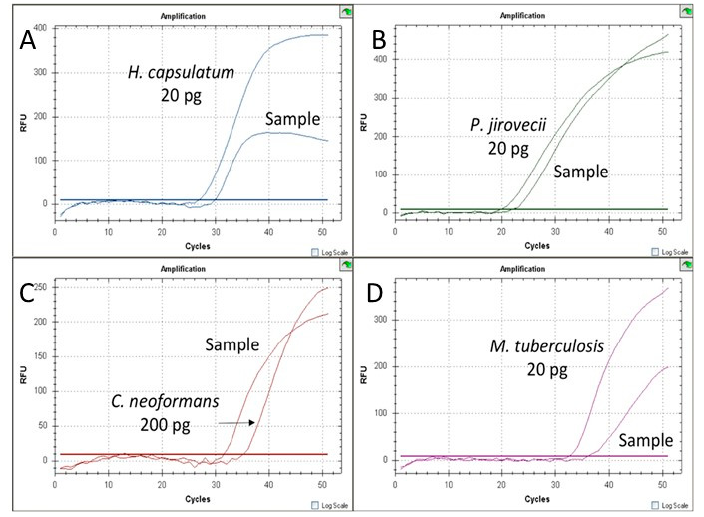
Figure 3. Representative MRT-PCR (multiplex real-time PCR) assay including different positive clinical samples and positive controls. ( A ) Histoplasma capsulatum detection, FAM fluorophore; ( B ) Pneumocystis jirovecci detection, HEX fluorophore; ( C ) Cryptococcus neoformans/gatti detection, Cy5 fluorophore.; ( D ) Mycobacterium tuberculosis complex detection, Cy5.5 fluorophore (corresponding to Quasar 705